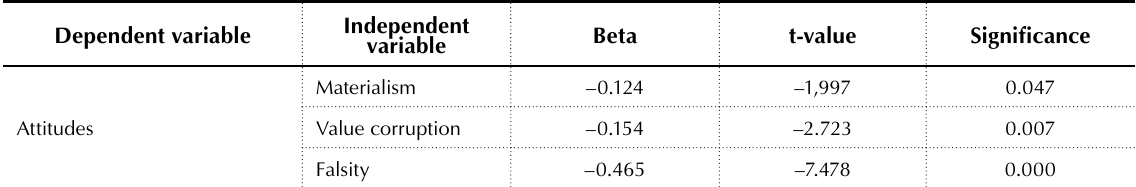
Table 2. Regression of negative factors of beliefs toward advertising on